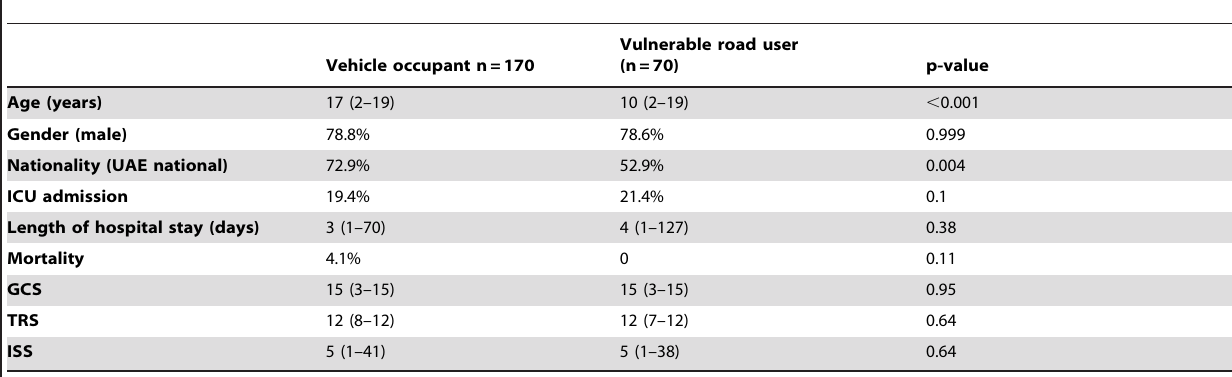
Table 2. Demographic and severity variables by road user type, Al Ain, 2006–2007 (n =245).